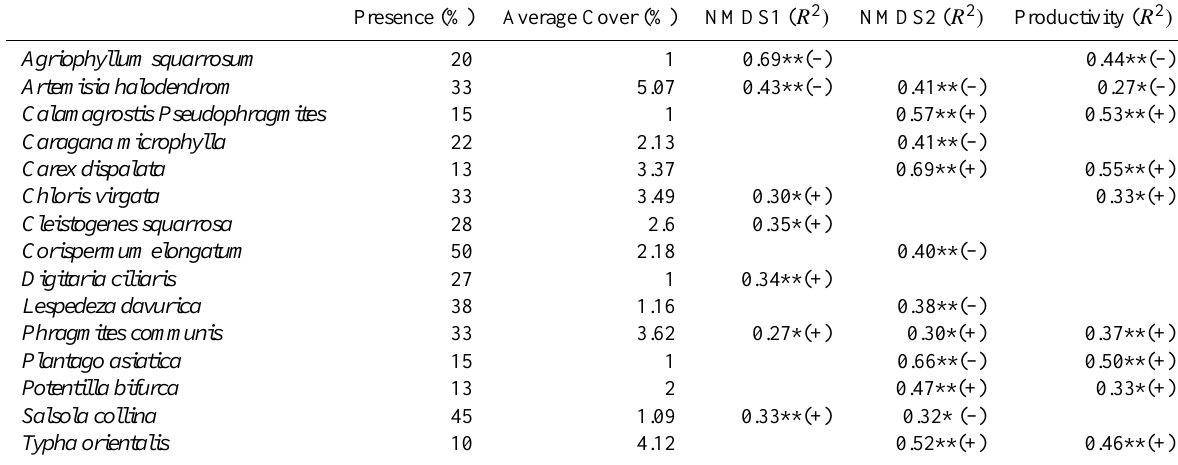
Table A3. Relative presence and average cover of those plant species in all 60 sites that explain > 8% of the variance of the non-metric multidimensional scaling (NMDS) axis and > 7% of variability in productivity in simple linear regressions. + and – signs represent the direction of the